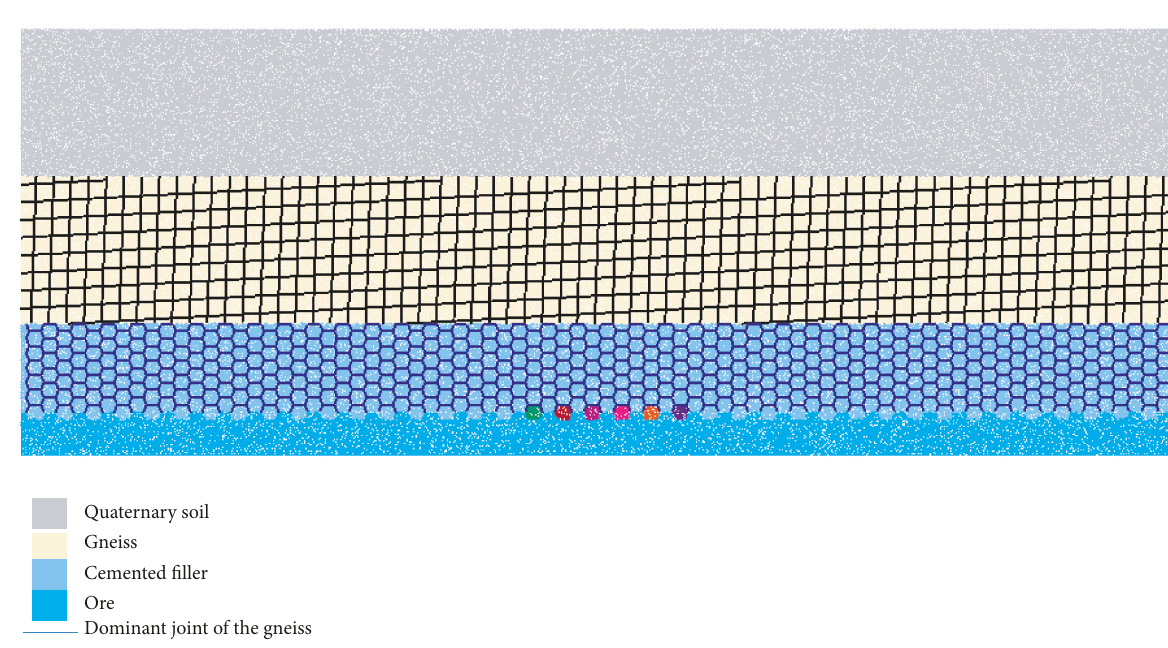
Figure 14: The PFC numerical model of the simplified 11#